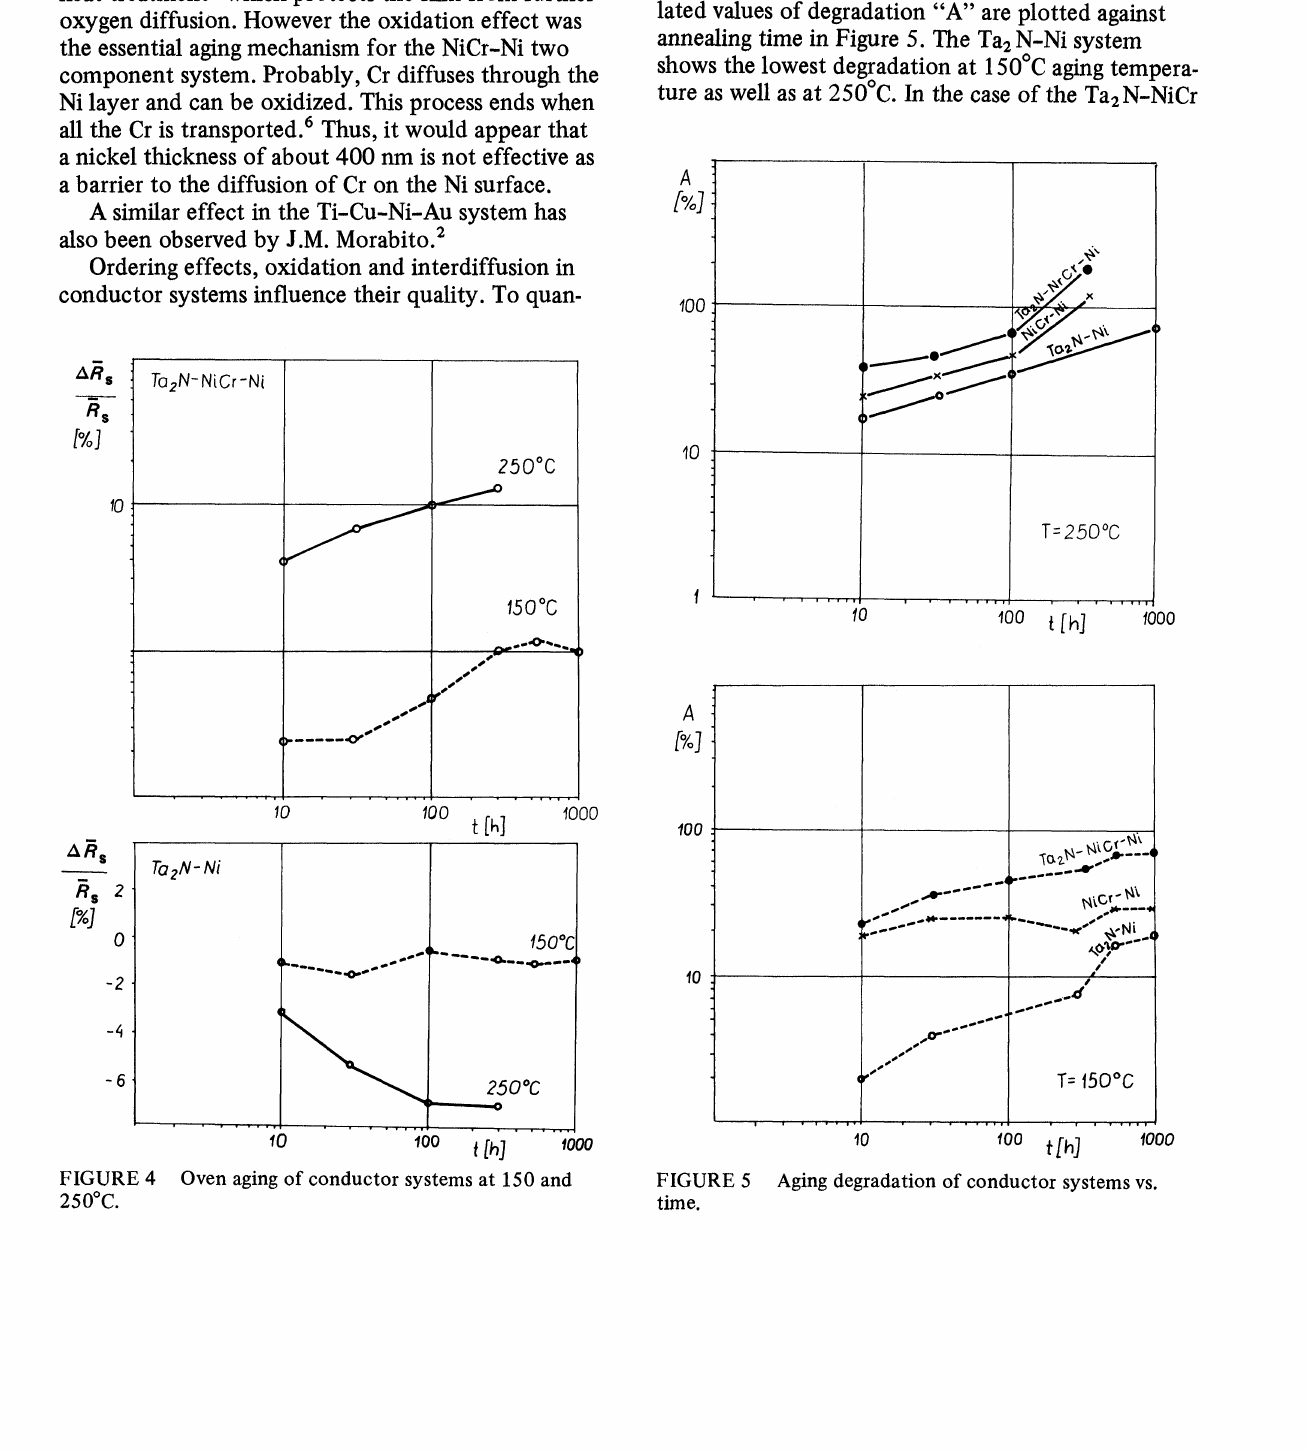
Oven aging of conductor systems at 150 and 250C.